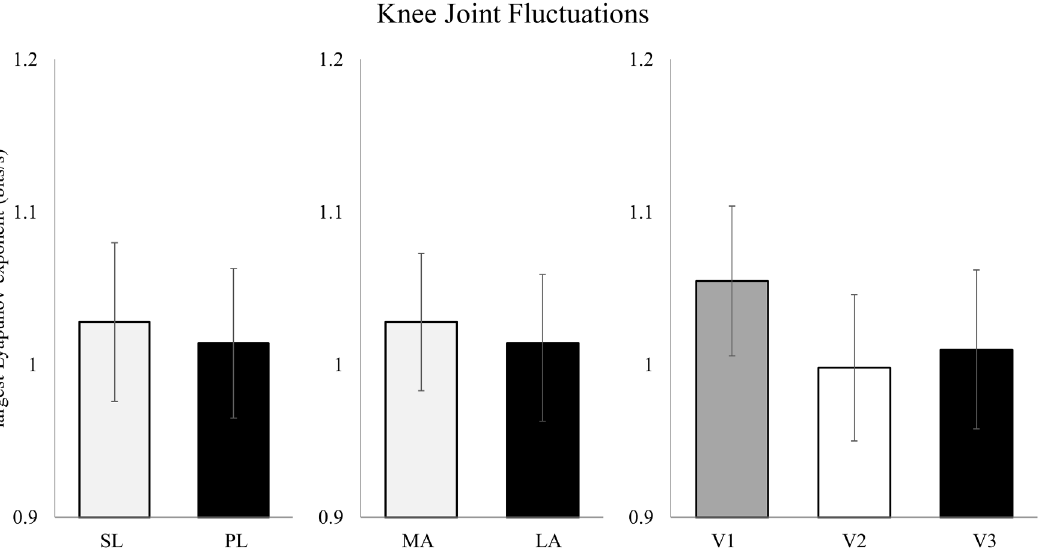
Figure 2. Differences in stride-to-stride fluctuations for the knee were not significant for the effect of leg, prosthesis, or time point in the adaptation period. (mean 6 SEM) SL: sound leg; PL: prosthetic leg; MA: ‘‘more appropriate’’ prosthesis; LA: ‘‘less appropriate’’ prosthesis; V1: initial visit; V2: second visit; V3: final visit. *Sig. at p , 0.05.